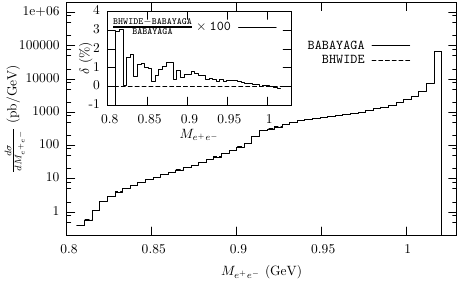
Figure 2. Comparison between BabaYaga@NLO and Bhwide on the final-state invariant mass